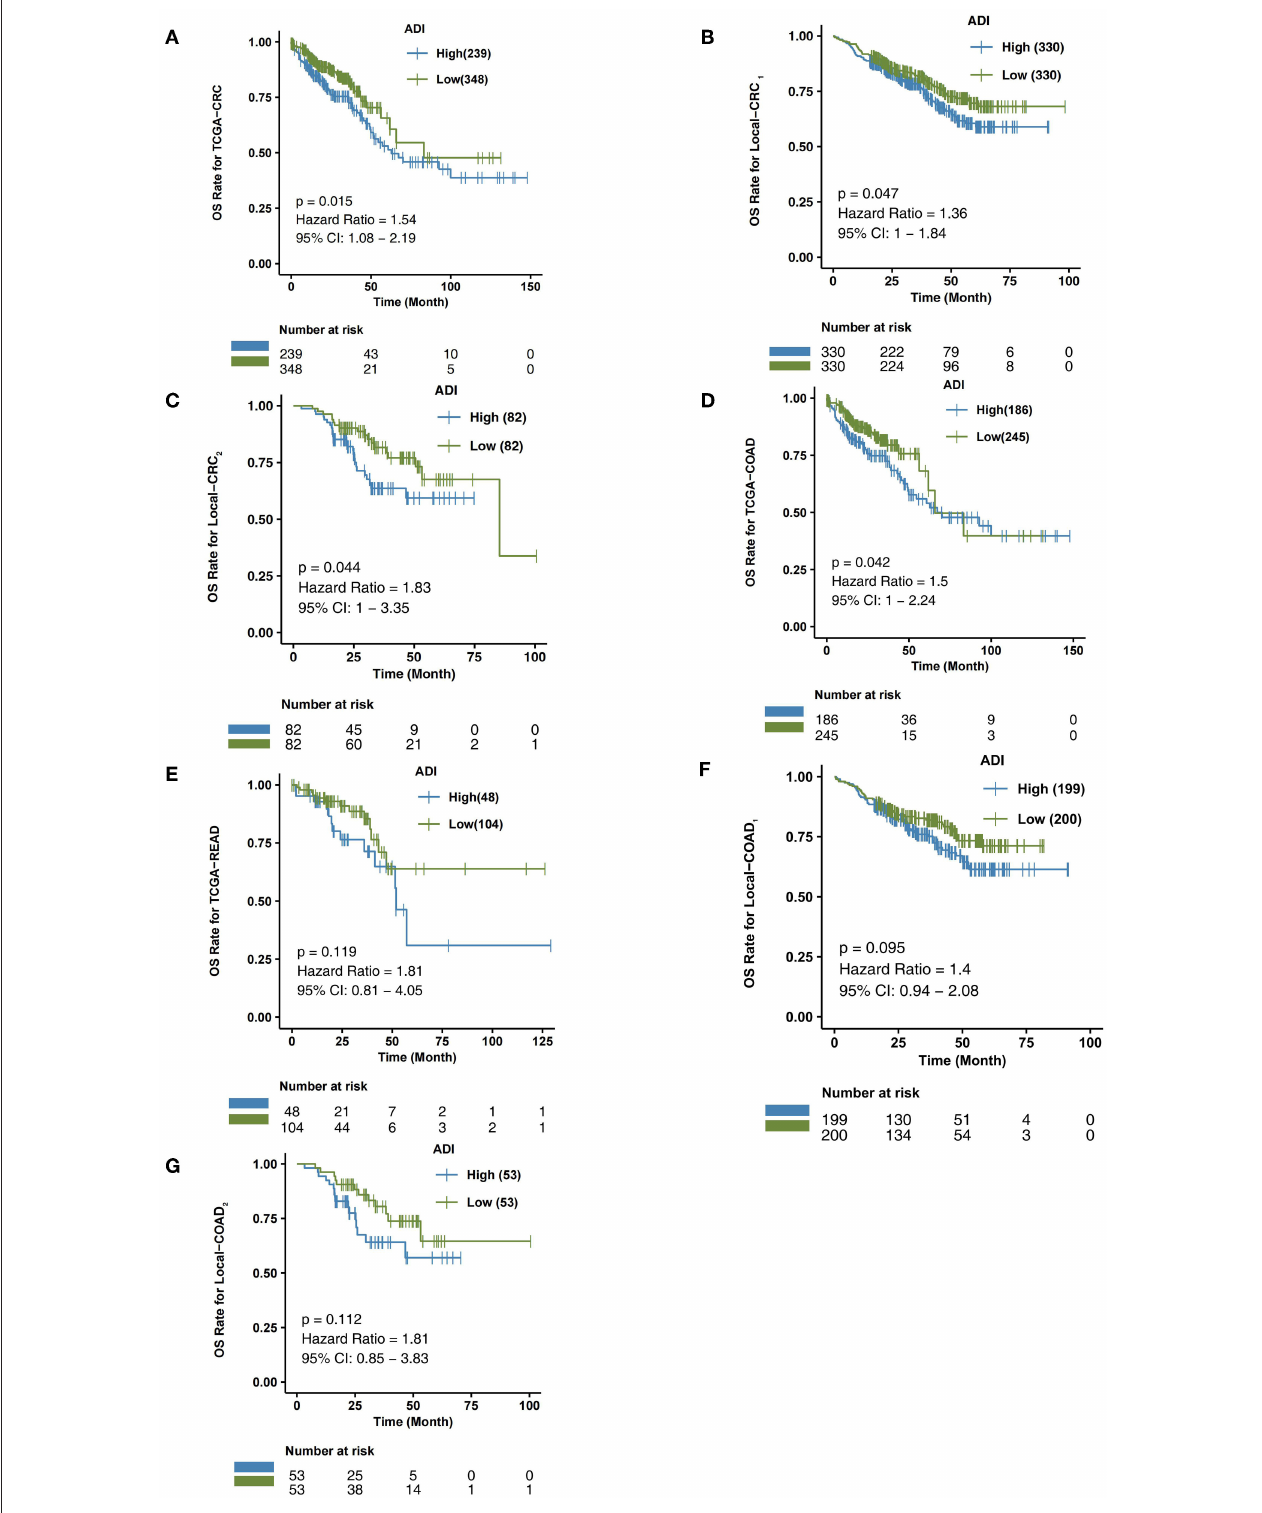
FIGURE 3 | The association between ADI and OS of CRC patients. Overall survival for subjects grouped according to ADI subclass (high-ADI and low-ADI) in the TCGA-CRC cohort (A) , Local-CRC1 (B) , Local-CRC2 (C) , TCGA-COAD (D) , TCGA-READ (E) , Local-COAD1 (F) , and Local-COAD2 (G) .